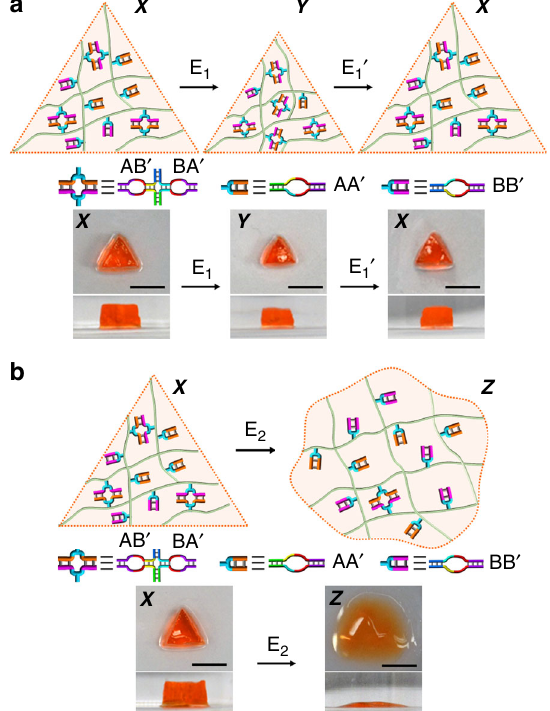
Fig. 3 Visual imaging of the stiffness changes of the triggered CDN hydrogels. a The E 1 -induced transition of the medium-stiffness CDN hydrogel X to the stiffer CDN hydrogel Y and the E 1 ’ -stimulated reverse process. The transition of hydrogel X to the stiffer hydrogel Y is evident by the shrinkage of the triangle-shaped hydrogel. The E 1 ’ -induced transition of hydrogel Y to X is evident by the regeneration of the original larger size of the triangle. b The E 2 -induced transition of the triangle-shaped, medium- stiffness hydrogel X into the low-stiffness CDN hydrogel Z. Scale bars in all images correspond to 0.5 cm